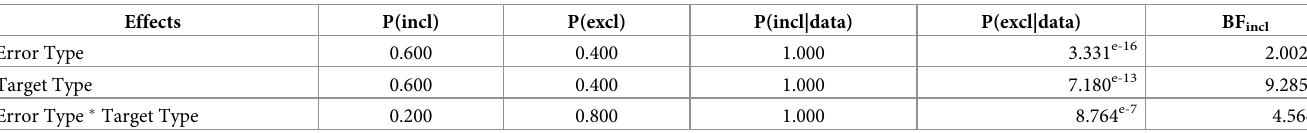
Table 5. Error rates